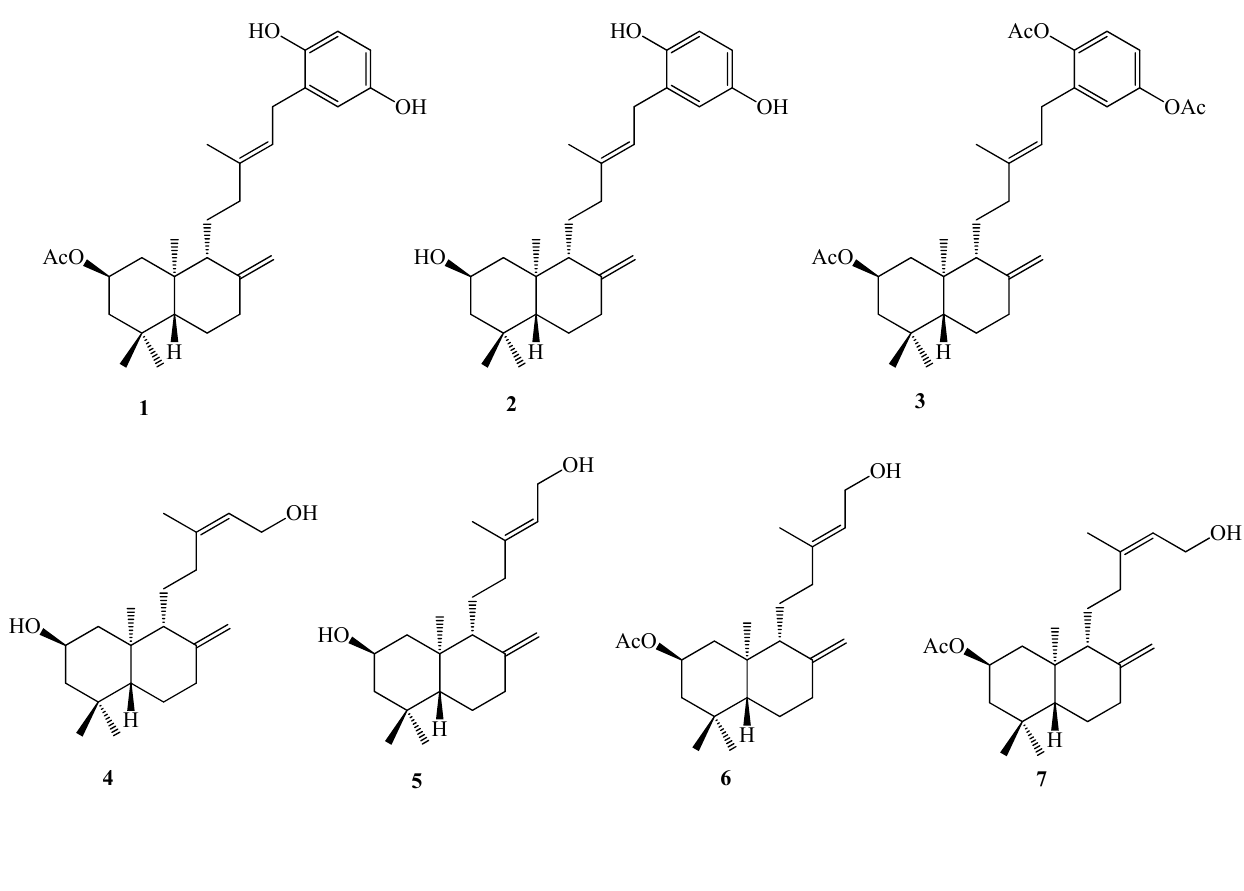
Figure 1. Structures of the seven